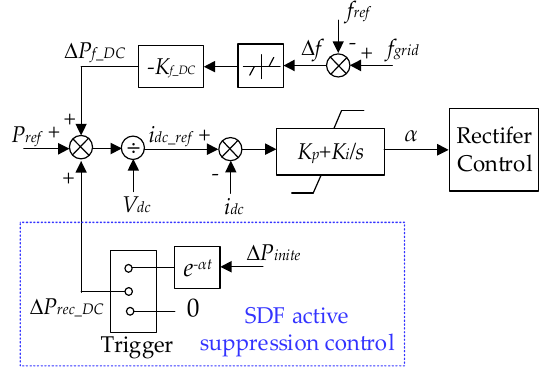
Figure 10. SFD active suppression control for HVDC.